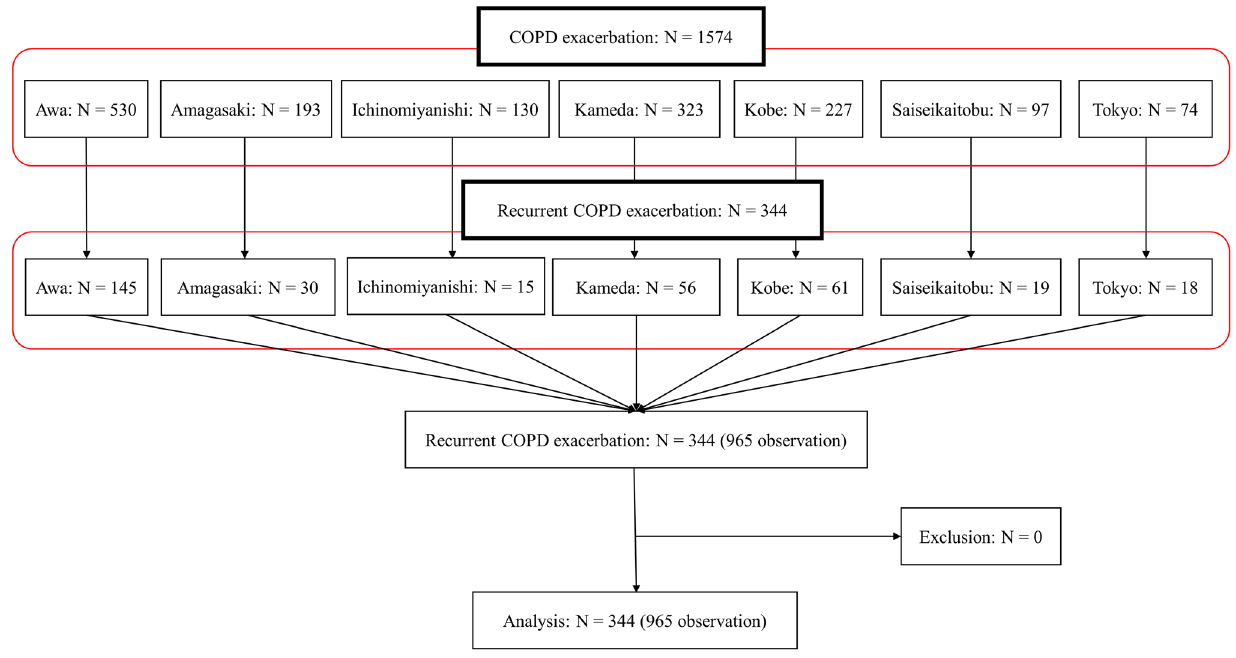
Figure 1. Patient selection flowchart. COPD = chronic obstructive pulmonary